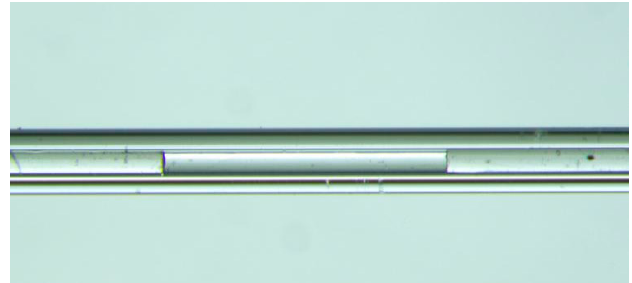
Figure 9. Schematic of the experimental system for cavity-length interrogation.